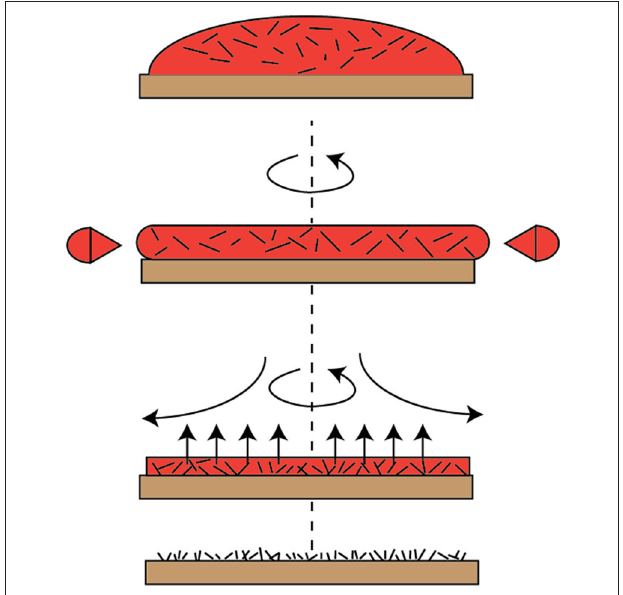
FIGURE 4 | Spin coating process to ensure uniformity of flow and proper